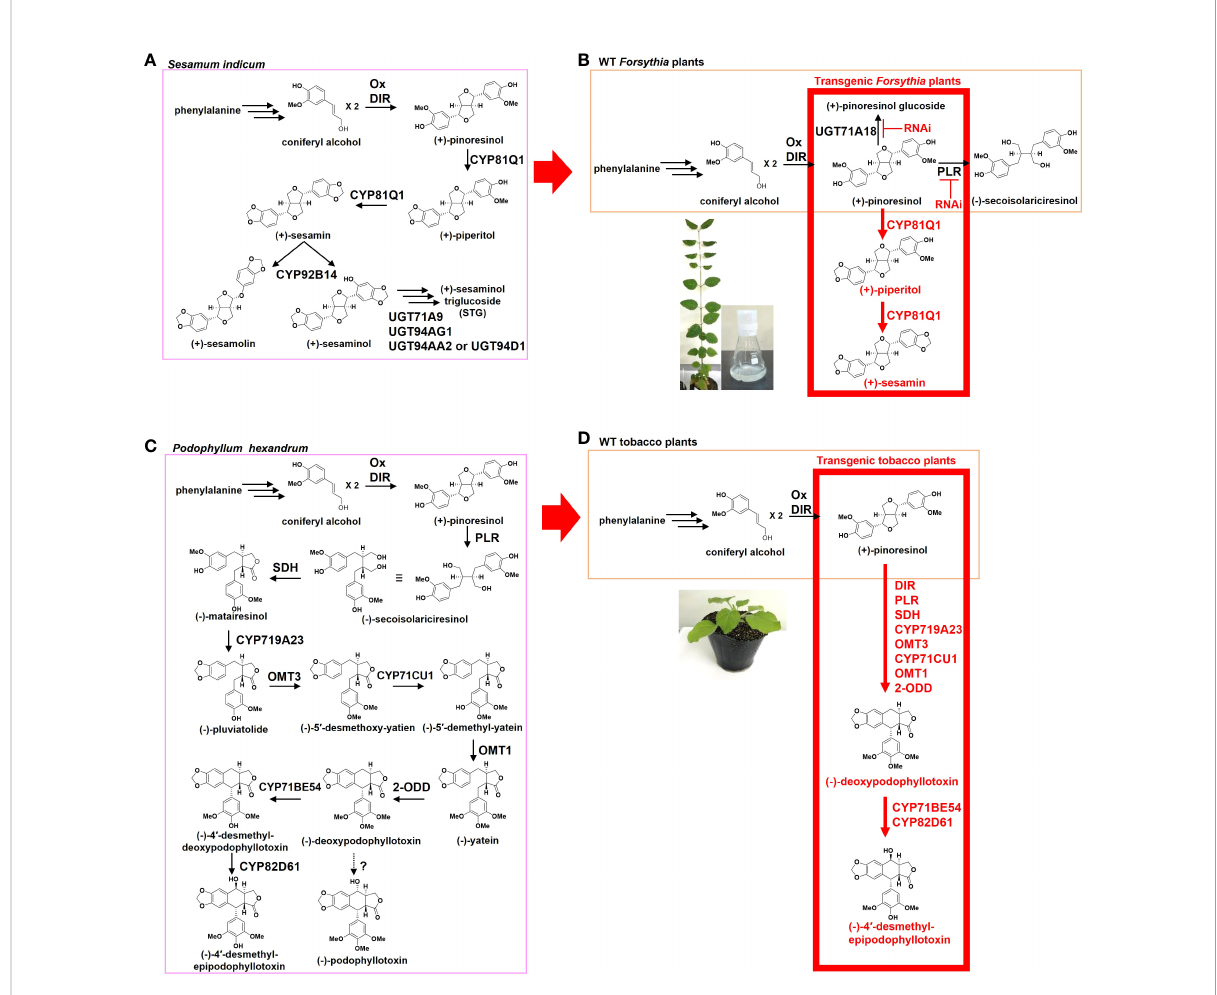
FIGURE 1 The heterologous production of bene fi cial lignans in transgenic plants. (A) Sesamum indicum lignan-metabolic pathway (pink). (B) Heterologous production of sesame lignans in Forsythia plants. Wild-type (WT) Forsythia plants biosynthesize (+)-pinoresinol (orange). Ectopic expression of CYP81Q1 gene produces sesame lignans, (+)-piperitol, and (+)-sesamin in transgenic Forsythia plants (red). RNAi of PLR and UGT71A18 increase the accumulation of (+)-sesamin in transgenic Forsythia cells. (C) Podopophyllum hexandrum lignan-metabolic pathway (pink) (D) Heterologous production of Podopophyllum lignans in tobacco plants. WT tobacco plants biosynthesize (+)-pinoresinol (orange). Transient co-expression of DIR, PLR, SDH, CYP719A23, OMT3, CYP71CU1, OMT1, and 2-ODD genes produces (-)-deoxypodophyllotoxin in the leaves of tobacco (red). Co- expression of additional cytochrome P450 enzymes (CYP71BE54 and CYP82D61) produces (-)-4 ′ -desmethyl-epipodophyllotoxin (etoposide precursor). DIR, Dirigent proteins; PLR, Pinoresinol-lariciresinol reductase; SDH, Secoisolariciresinol dehydrogenase; OM,: O -methyltransferase; 2-ODD, 2-oxoglutarate/Fe(II)-dependent